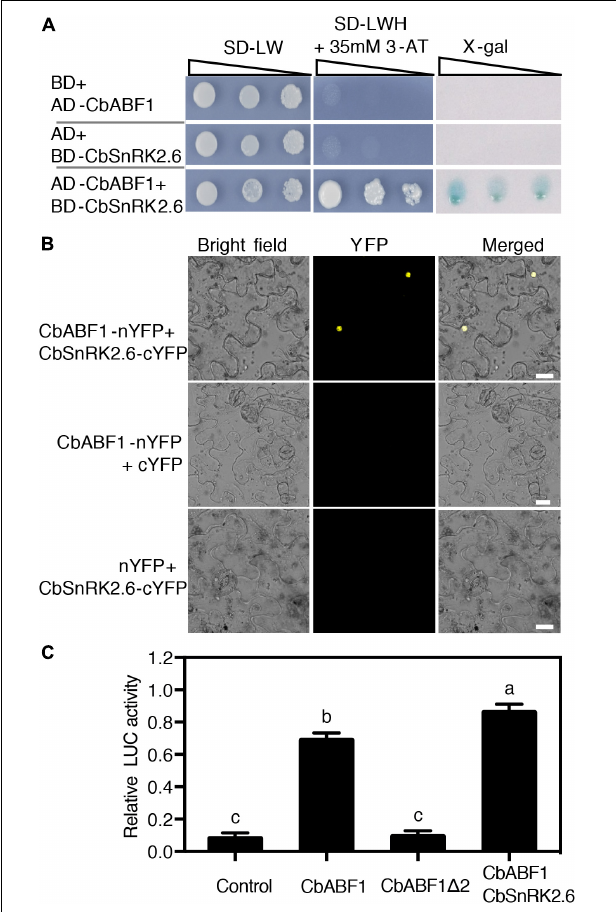
FIGURE 5 | CbABF1 interacts with CbSnRK2.6. (A) CbABF1 interacts with CbSnRK2.6 as determined by yeast two-hybrid assays. Yeast strain Mav203 co-transformed with CbSnRK2.6-pDEST32 (bait) and CbABF1-pDEST22 (prey) was subjected to the X-gal assay. Mav203 cells co-transformed with CbSnRK2.6-pDEST32/pDEST22 (empty vector) or CbABF1-pDEST22/ pDEST32 (empty vector) were used as negative controls. Ten-fold dilution series (10 − 1 to 10 − 3 ) of transformants were spotted on SD medium –LW, or SD medium –LWH + 3-AT. The plates were incubated at 30 ◦ C for 4 days and subjected to the X-gal assay. (B) CbABF1 interactions with CbSnRK2.6 in vivo as determined by bimolecular fluorescence complementation (BiFC) assays in tobacco leaf epidermal cells. Bars = 20 µ m. Yellow fluorescent protein was detected at an approximate frequency of 3.04% (86 out of 2,830 tobacco leaf epidermal cells analyzed exhibited BiFC events). (C) Relative luciferase activity from the dual luciferase reporter assays of RD29B promoter containing ABRE elements in tobacco leaves. CbABF1 (cid:49) 2 is the C-terminal fragment mentioned in Figure 4 . Error bars represent SD ( n = 12). One-way ANOVA (Tukey–Kramer test) was performed, and statistically significant differences are indicated by different lowercase letters ( P < 0.01). Values shown are derived from experiments that were performed three times with similar results, and representative data from one repetition are